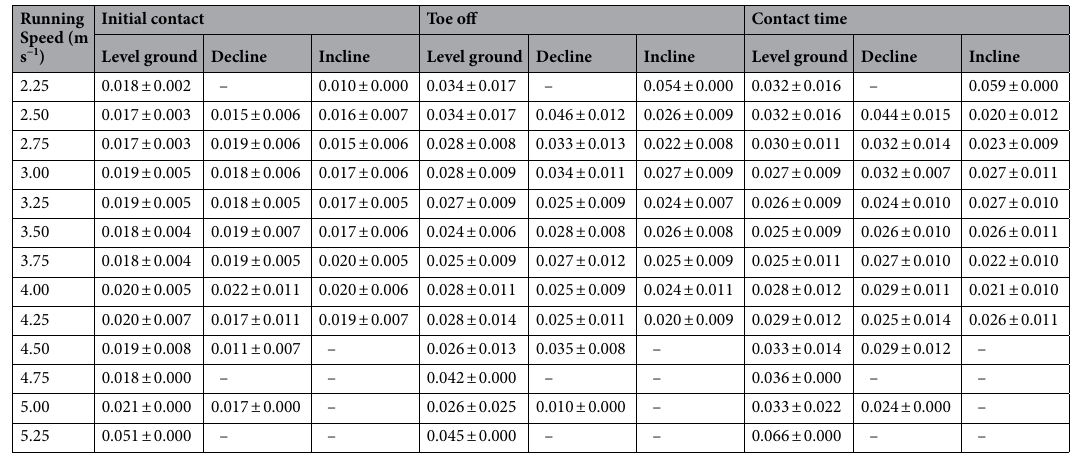
Table 2. IMU heuristic temporal variable RMSE.